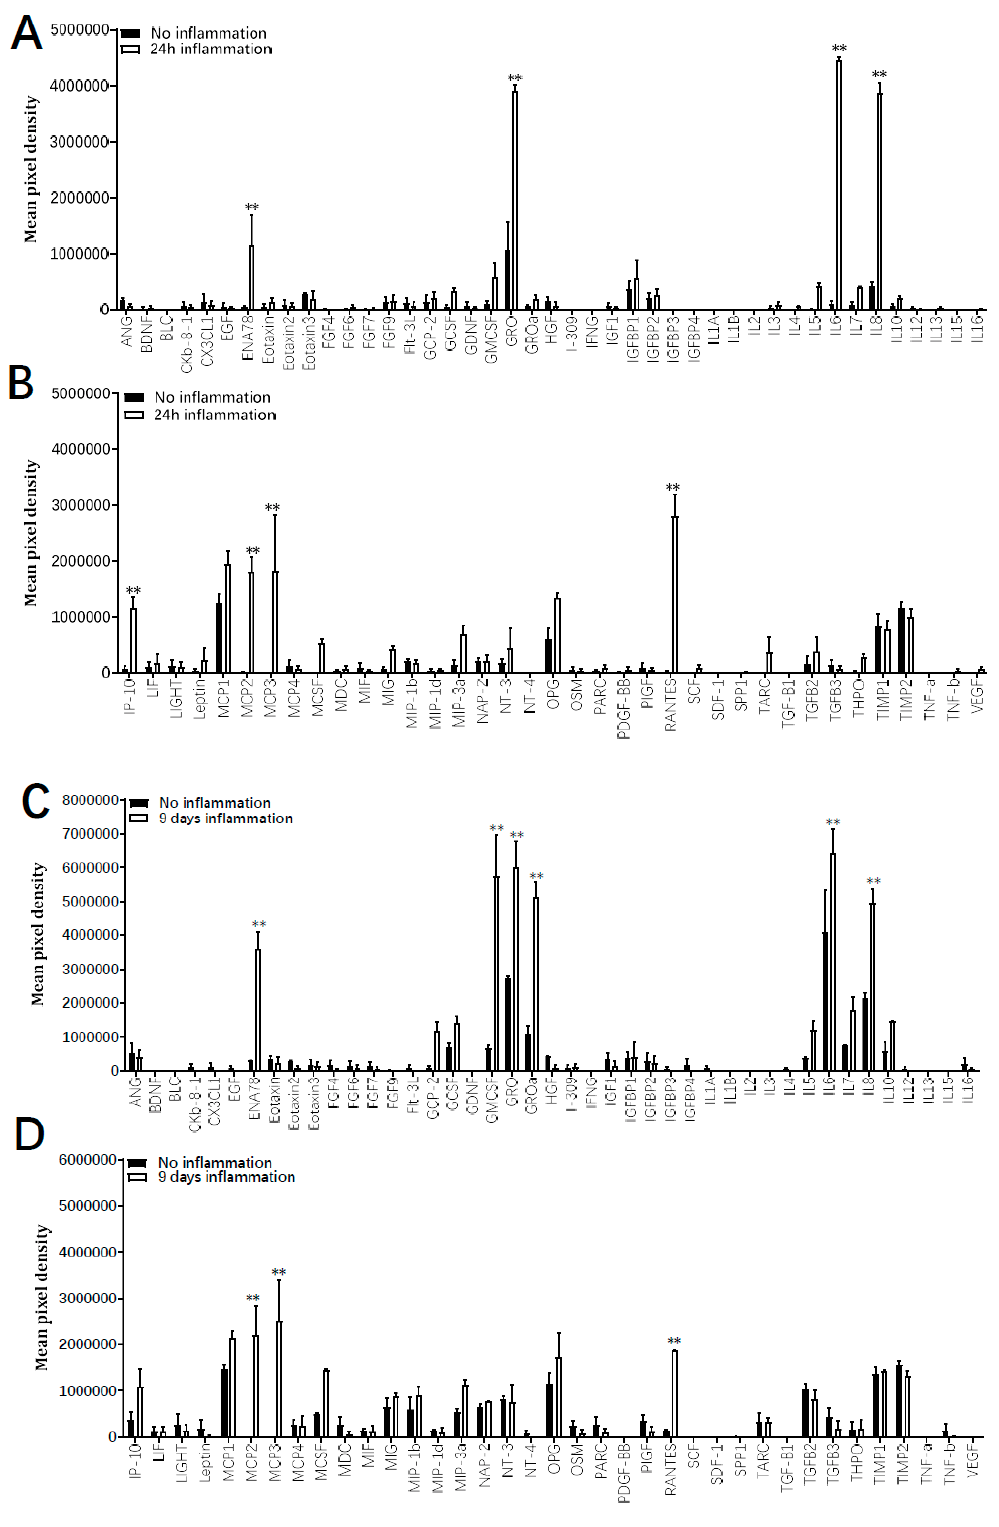
Figure 6. E ff ect of inflammation on ADHLSC secretion profile. Secretion profile was evaluated on supernatants from ADHLSC untreated and treated with the inflammation cocktail using the